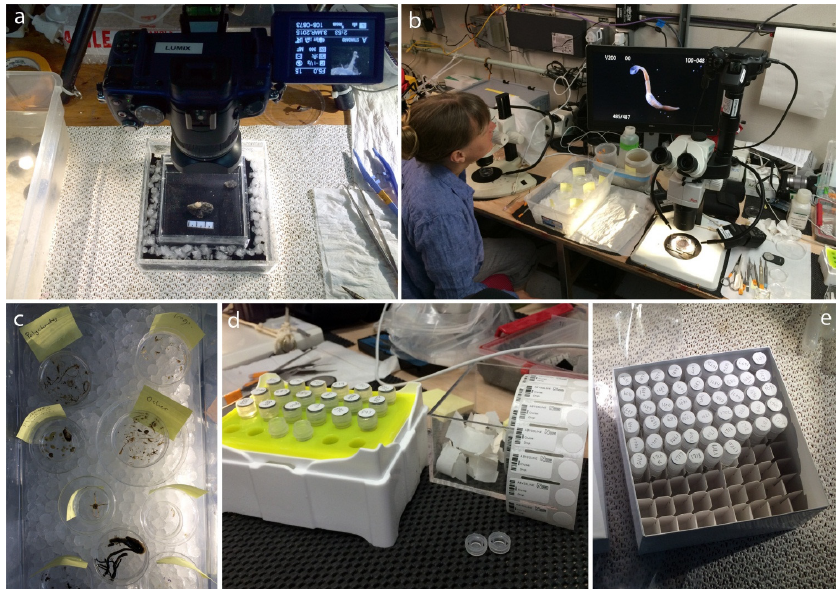
Figure 14. Live sorting at sea for DNA taxonomy in the Clarion Clipperton Zone. ( a ) Polymetallic nodule with sessile macrofauna imaged live while kept cool on ice using macro-photography suite; ( b ) Typical photomicroscope setup showing sorting tray (with ice), camera system with HD viewing screen showing live image, wet black cloths under petri dishes to create black backgrounds, strobe lighting to improve resolution and dissecting tools; ( c ) Typical live sorting of an EBS sample into class prior to imaging and preservation; ( d ) Low-temperature micro-tube rack (insulated) for storing vials, each given barcoded labels and unique specimen number; ( e ) Specimens transferred into storage boxes prior to being placed in − 20 °C freezer and shipment to laboratory at end of cruise. This process is also illustrated in the Electronic Supplementary Information (Video).